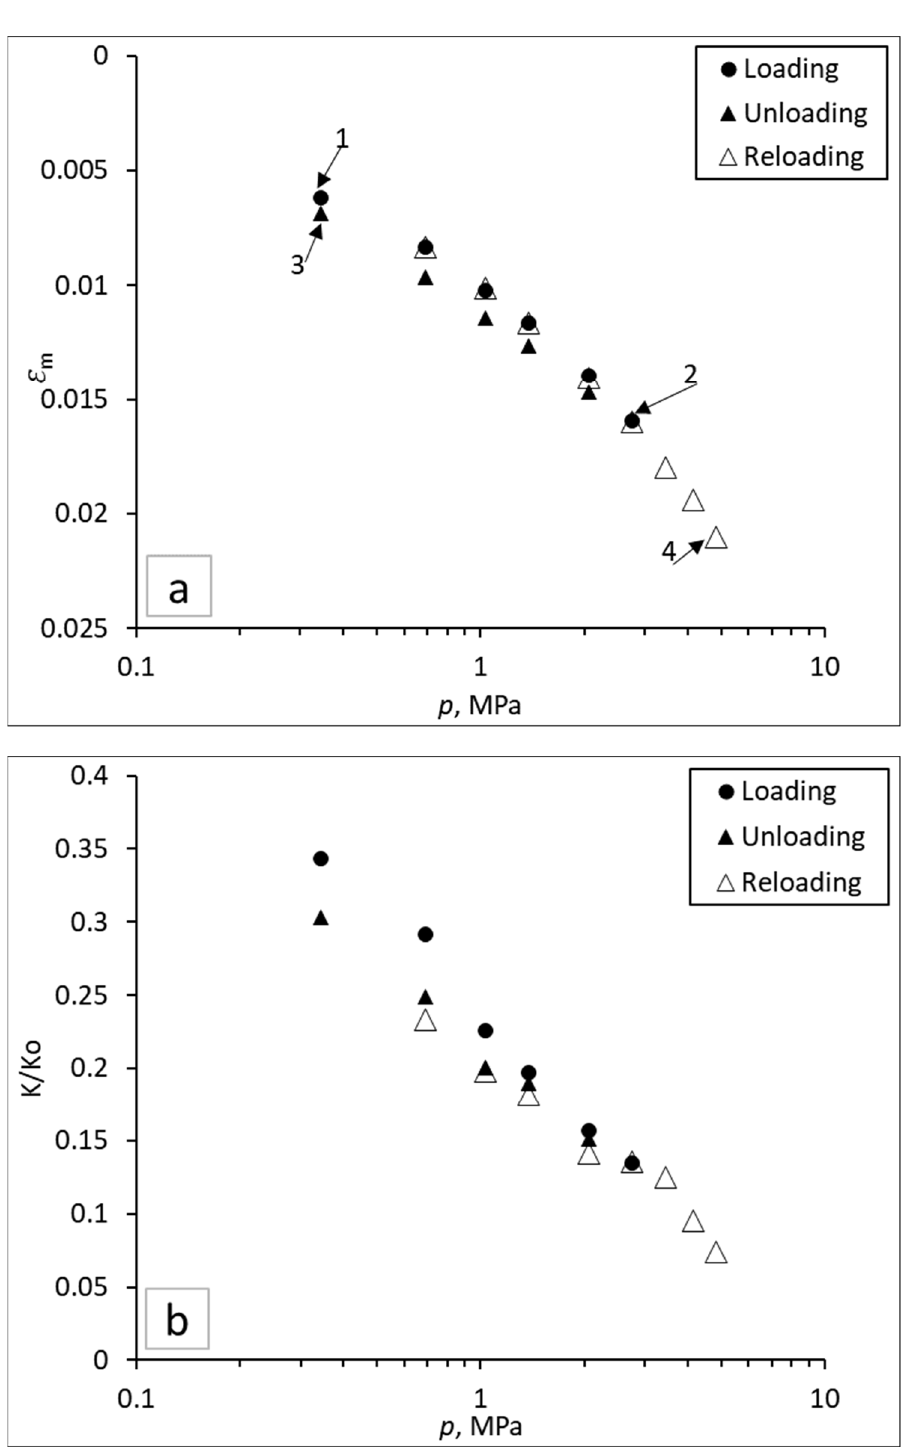
Figure 10. Strain and permeability hysteresis during stress loading–unloading–reloading (up to 4.8 MPa in test 4).